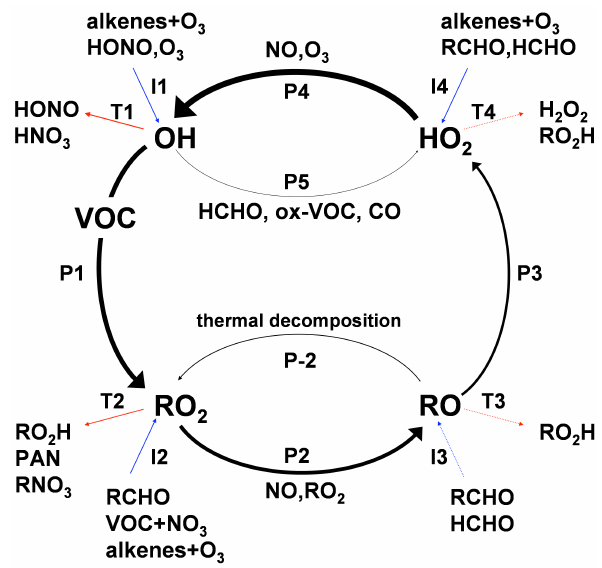
Fig. 1. The schematic of RO x cycling in MCMA is shown. Only the predominant species involved in radical sources, sinks, and cycling are shown. Radical pathways are labeled as initiation (I), propa- gation (P), or termination (T), and assigned a number for cross- referencing in Table S1 (see Supplemental Information). The thick- ness of each arrow corresponds to the magnitude of the radical path- way, as determined in the HO x -unconstrained